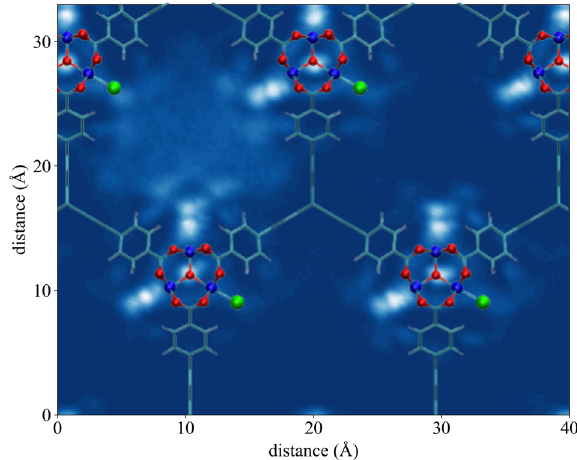
Fig. 4 Water spatial distribution in NU-1500-Cr. Two-dimensional water densitydistribution in the hexagonal poresof NU-1500-Cr calculatedat 34.6% RH. Color scheme: C = cyan, H = white, O = red, Cr = blue, Cl = green.